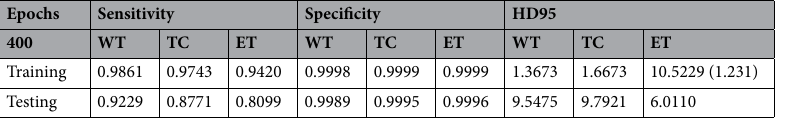
Table 6. Sensitivity, specificity and HD95 for the WT, TC, and ET for the training and testing sets with 400 epochs.